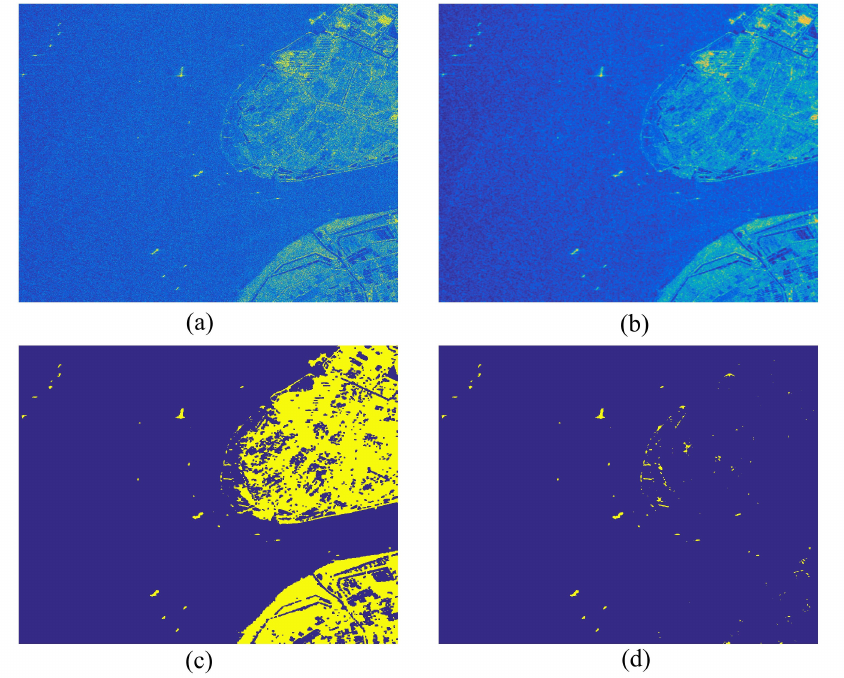
Figure 3. Preprocessing. ( a ) Original SAR image; ( b ) after mean-filtering; ( c ) after Otsu and morpho- logical offset; ( d ) after land